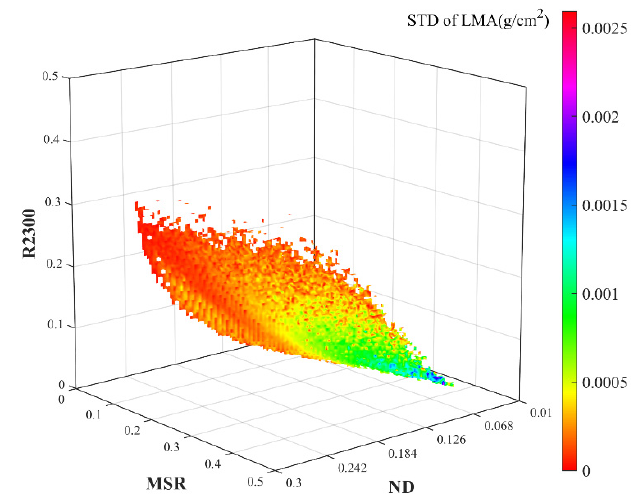
Figure 4. The standard deviation 3D matrix of MSR-ND-R2300.